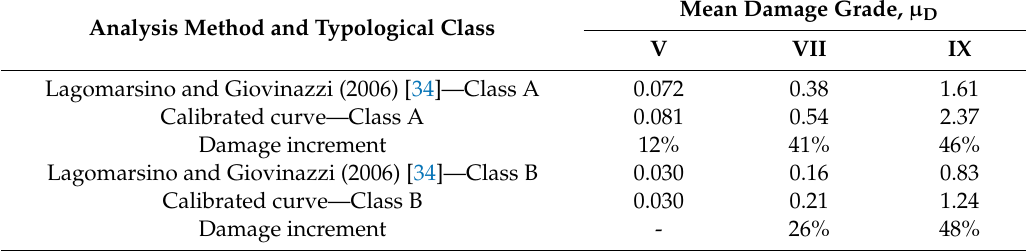
Table 4. Comparison in terms of mean damage grades between the proposed formulation results and Lagomarsino and Giovinazzi’s relationship ones for the macroseismic intensities recorded in the investigated area.